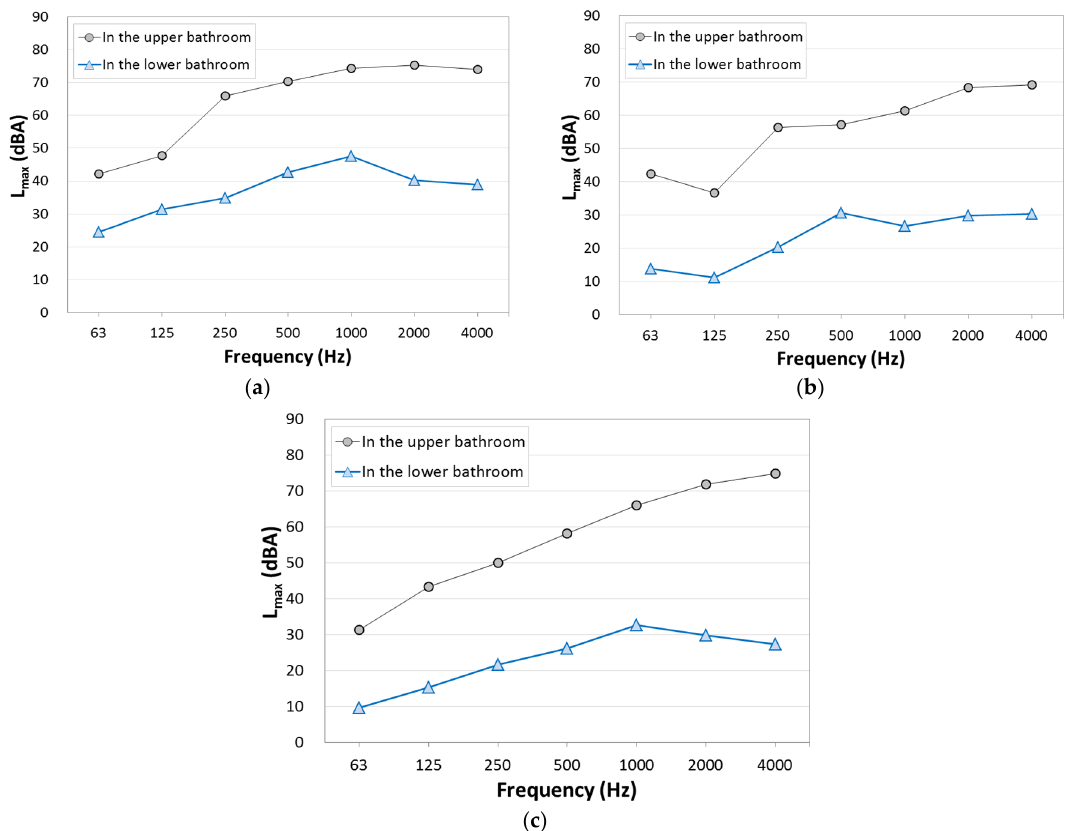
Figure 7. Frequency spectrum of the water supply and drainage noises (L AFmax ) from the use of the sanitary wares in the bathrooms attached to the living room of the upper and lower floors for the 59A type: ( a ) water closet; ( b ) basin; ( c ) bathtub.